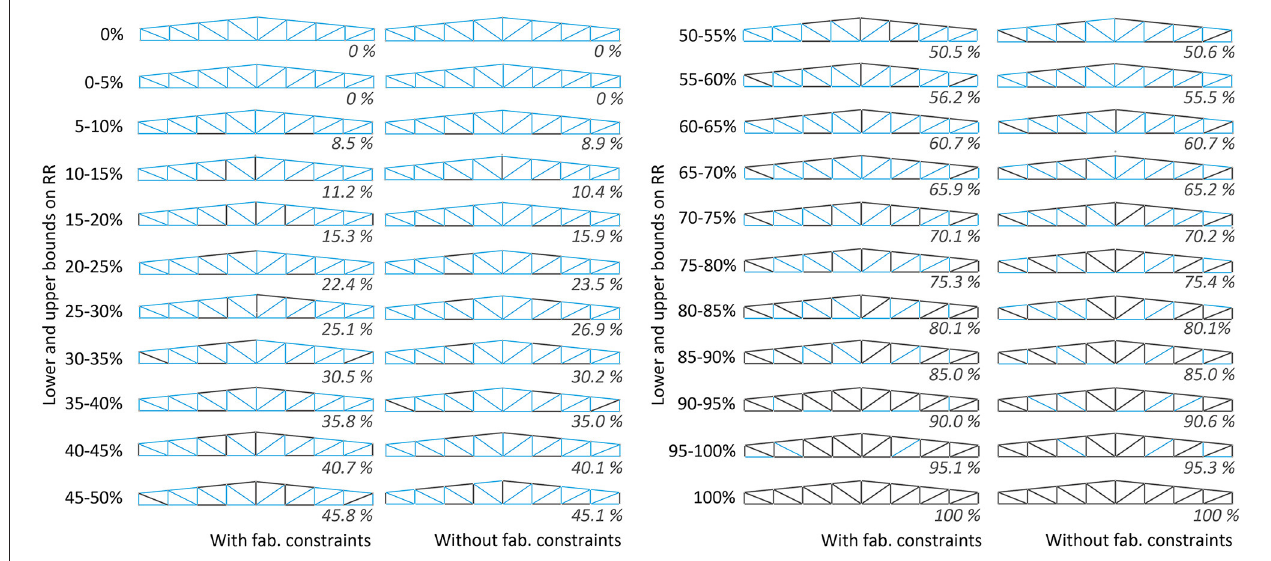
FIGURE 7 | The 44 alternatives generated through structural optimization. New components are represented in blue and reused ones in dark gray. Black numbers indicate the bounds on RR and dark-gray italic numbers indicate the actual RR obtained through